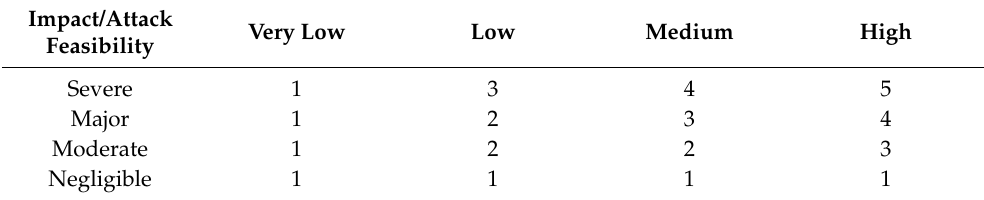
Table 6. Risk matrix scale used to obtain the final risk determination.